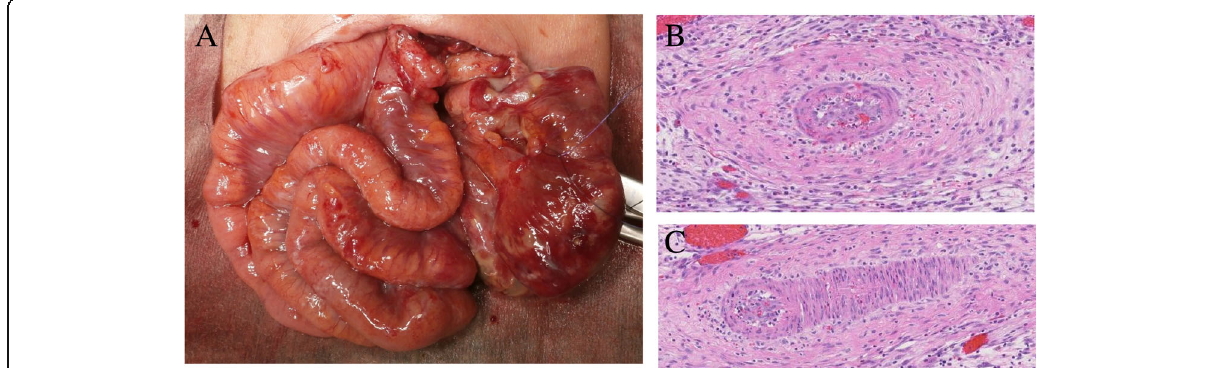
Fig. 3 Operation for necrotizing enterocolitis. a The color of the mesenteric artery was white, and the whole small intestine was pale. The length of the necrotic jejunum was only 15 cm. b , c Pathological examination revealed multiple thromboemboli in the mesenteric